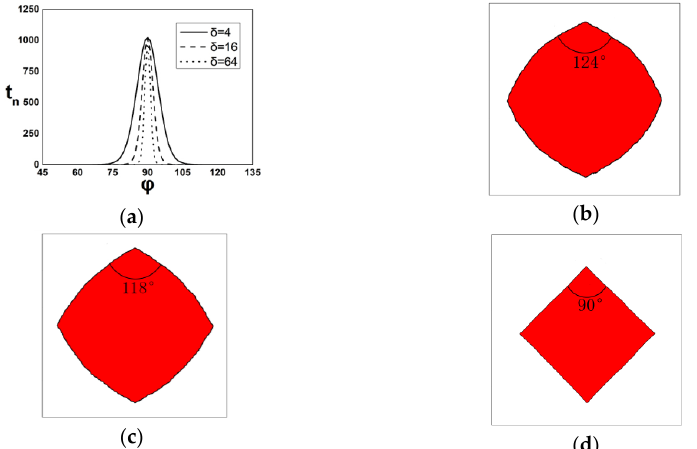
 Figure 7. Simulation results for δ : ( a ) the kinetic anisotropic functions with different values of δ ; ( b ) the Figure 7. Simulation results for : ( a ) the kinetic anisotropic functions with different values of